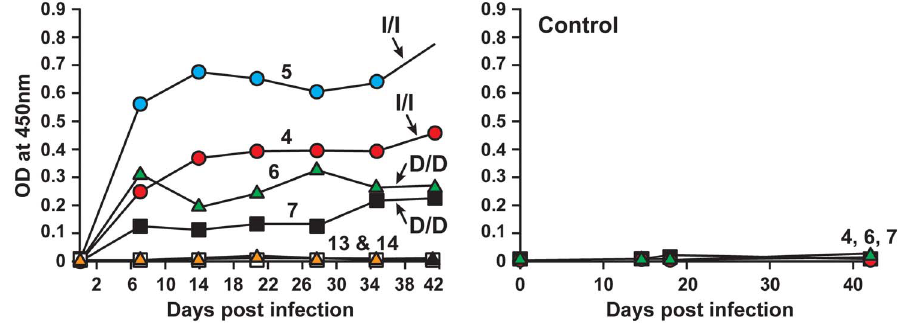
Figure 5. Antibody response in dogs i.v. infected with E.chaffeensis originating from ISE6 culture (dogs 4 and 5) and DH82 culture (dogs 6 and 7). D/D and I/I are as described in Figure 2. Dogs 13 and 14 are uninfected controls. Control panel on the right refers to the ELISA analysis performed on sera from animals using the uninfected host cell antigens.